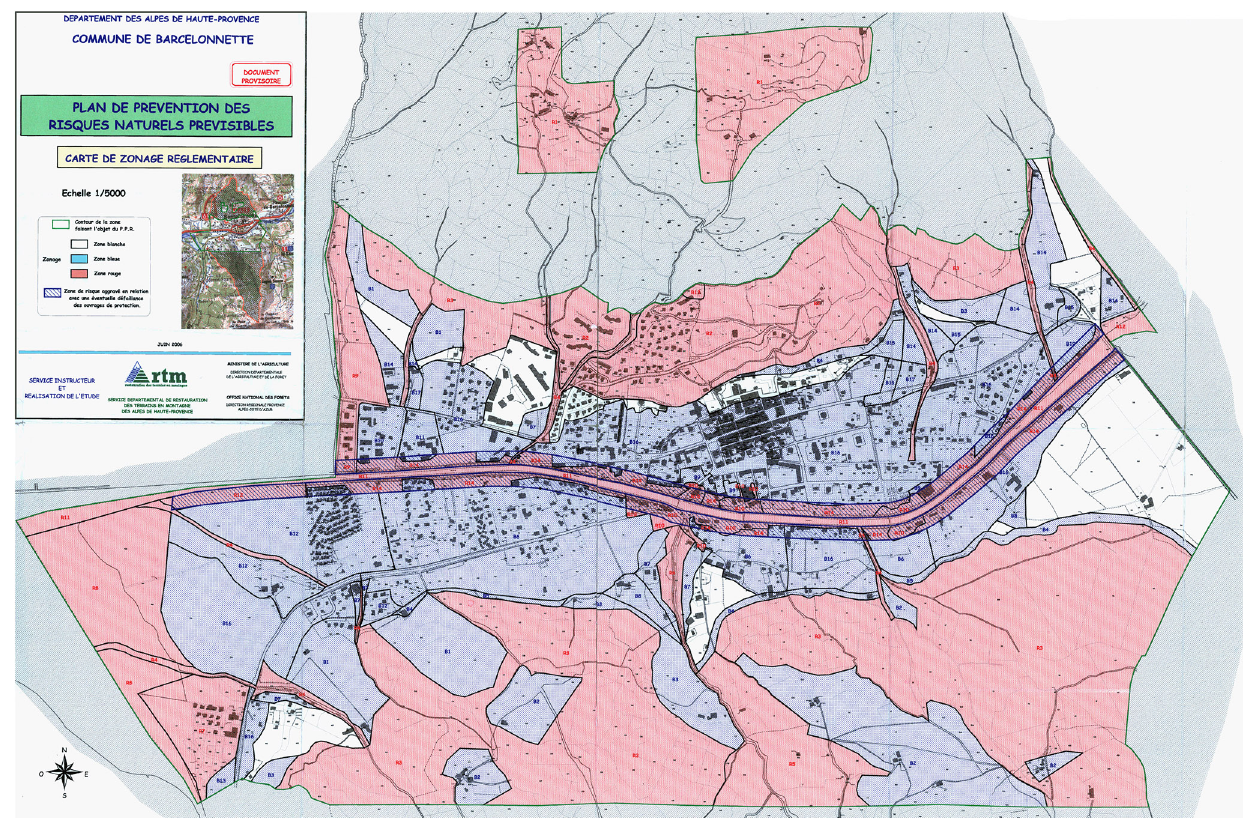
Figure 5. Plan de Prévention des Risques Naturels of Barcelonnette, France (RTM, 2006). Red areas indicate high risk, blue areas indicate medium risk and white areas indicate low or no risk. The three risk classes are based on a matrix comprising three hazard classes and four classes of potential consequences (exposed elements/vulnerability). The hazard comprises the probability of occurrence of an event, and the exposed elements can be defined as the entirety of persons, goods and infrastructures likely to be affected by a